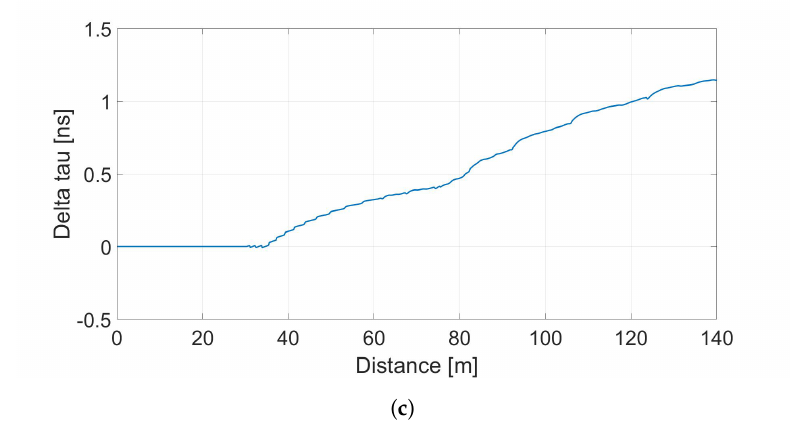
Figure 8. ( a ) Number of maximum rays arriving at the detector side for each distance inside Lincoln Tunnel, using a horn antenna, calculated from Equation (15). ( b ) Link budget along the first 140 m of the tunnel. ( c ) ∆ τ along the tunnel